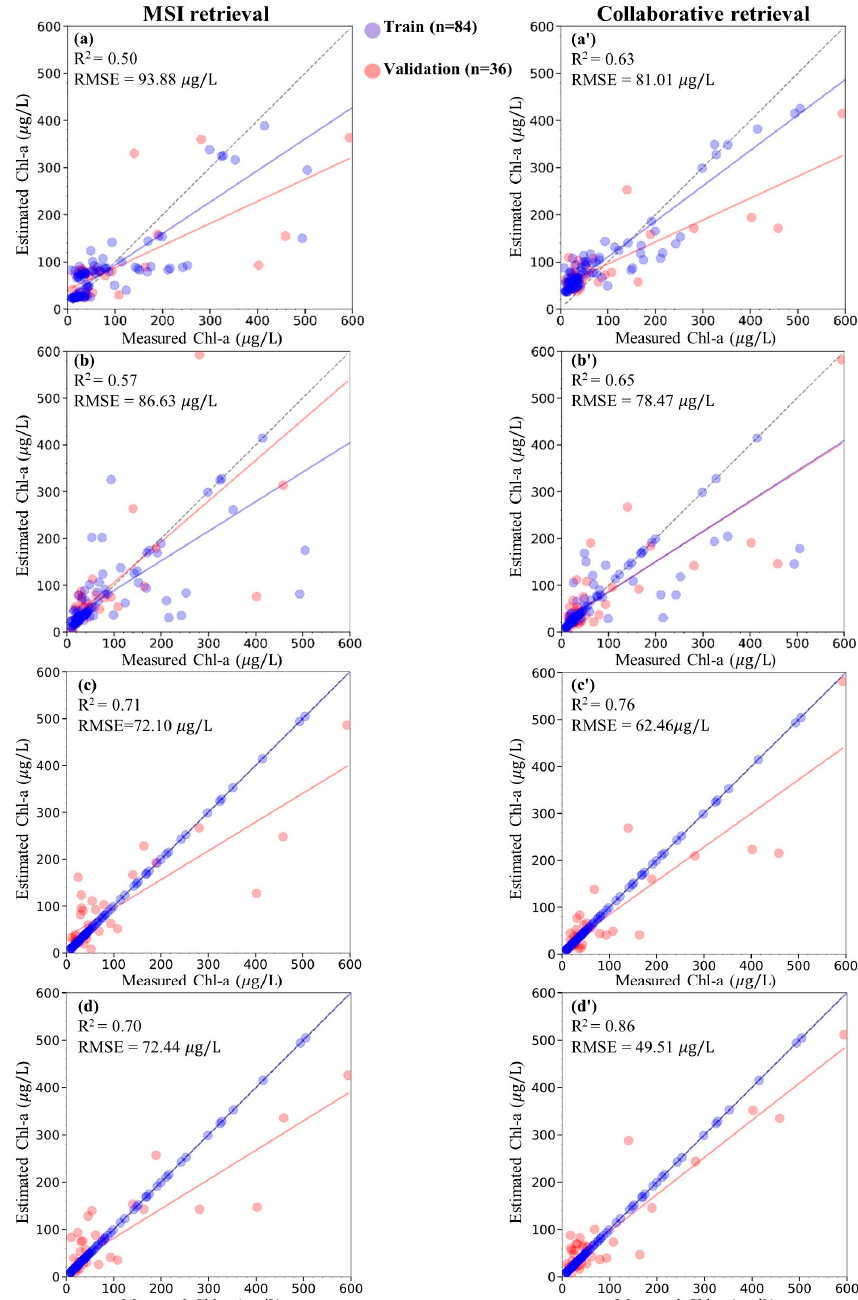
Figure 14. Statistical metrics of Chl-a retrieval using four machine learning models for MSI and collaborative retrieval based on Chl-a data from four dates. ( a , a' ) Adaboost model; ( b , b' ) SVR model; ( c , c' ) XGboost model; ( d , d' ) GBDT model.